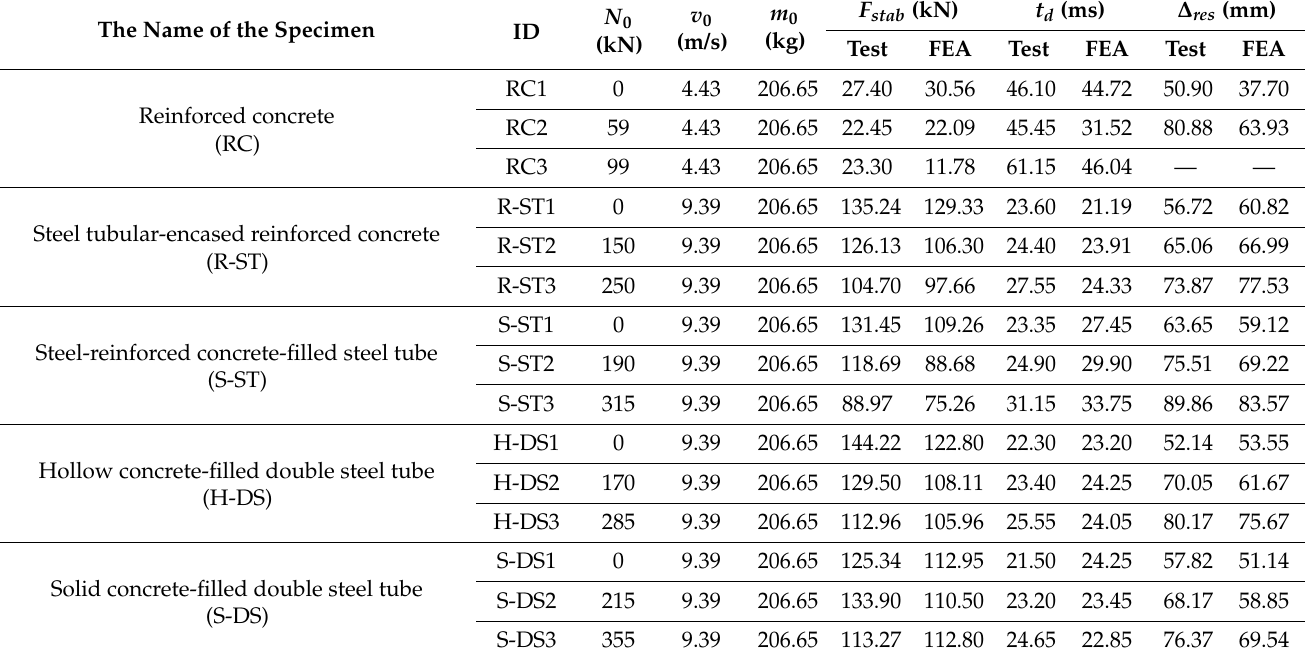
Figure 2. During the test, the column is allowed to deform freely along the axial direction. The axial load was maintained at designed axial load ratios of 0, 0.3 and 0.5. The boundary conditions of the composite column in the test are fixed at both ends for rotations, and the effective length ( L 0 ) of each specimen is 1200 mm (shown in Figure 1B).